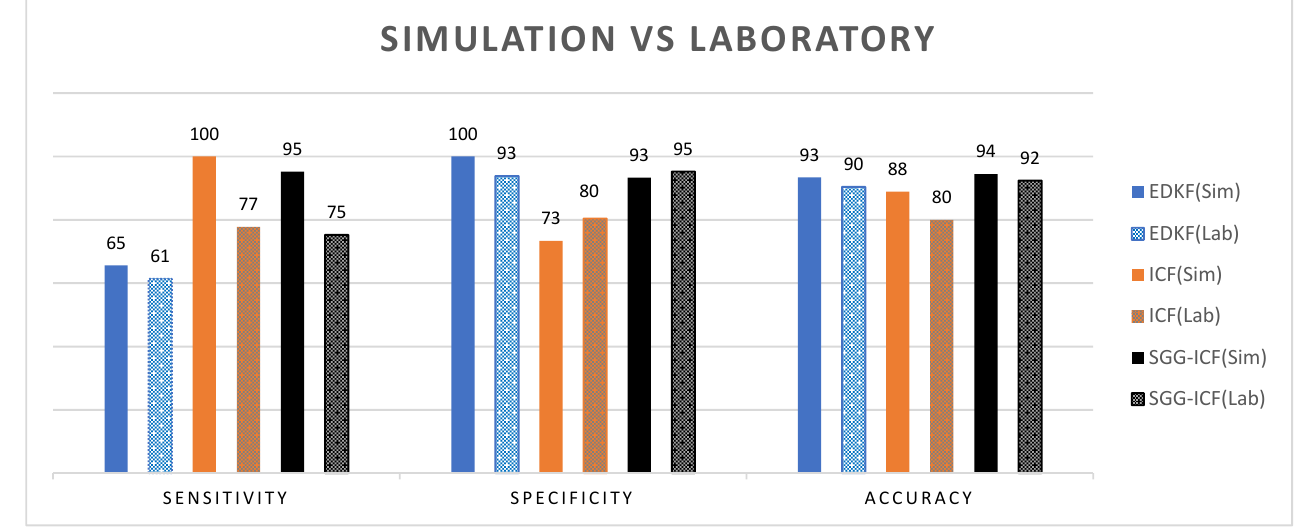
Figure 11. Comparison of simulation and experimental performance values.